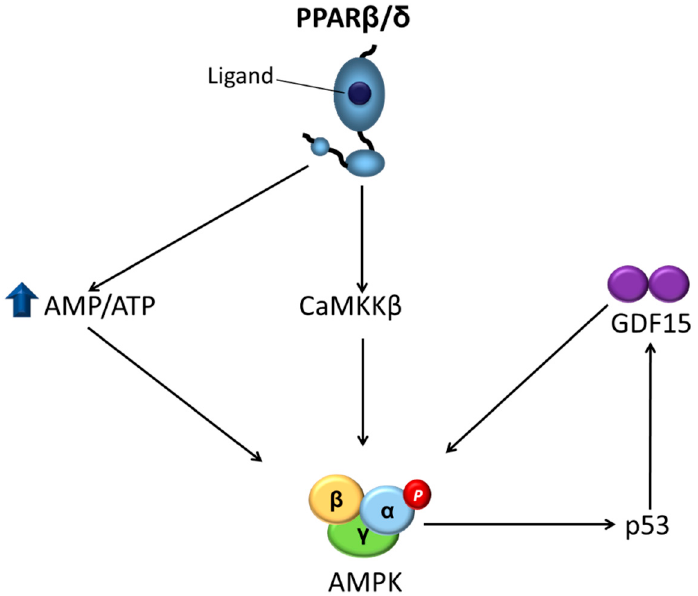
Figure 3. Mechanisms involved in the activation of AMPK by PPAR β / δ . AMPK is activated by PPAR β / δ through three mechanisms: (1) an increased AMP/ATP ratio; (2) an increased transcription of CaMKK β ; and (3) increased levels of GDF15 that sustain AMPK activation. AMPK, AMP-activated protein kinase; CaMKK β , Ca 2+ /calmodulin-dependent protein kinase kinase- β ; GDF15, growth differentiation factor 15; PPAR β / δ : peroxisome proliferator-activated receptor β / δ . In obesity, as the amount of visceral adipose tissue increases, so does the rate of li- polysis. This increases FA mobilization and raises the levels of circulating non-esterified